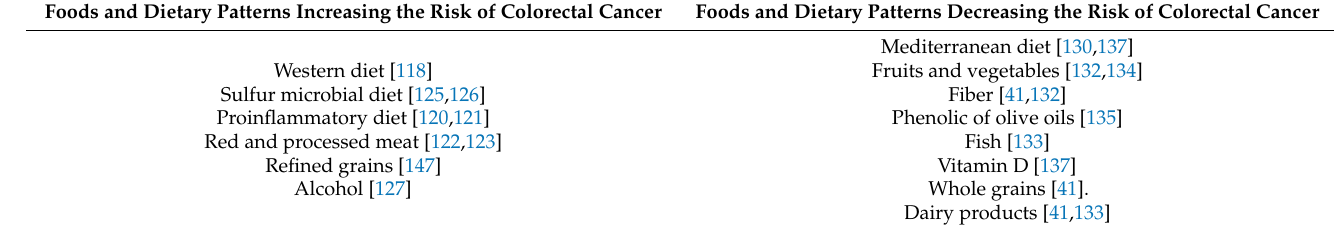
Table 2. Foods and dietary patterns increasing or decreasing the risk of colorectal cancer (dietary patterns are characterized in the